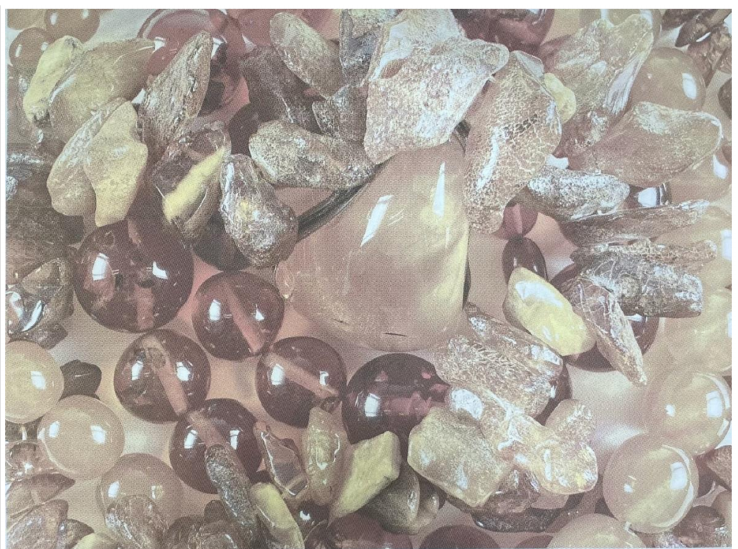
Figure A13. 25LPI screen-print, 55H mesh, Spectraval™ pigments, R = 400 g medium, 18 g pigment, G = 400 g medium, 24 g pigment, B = 400 g medium, 20 g pigment, black Plike, film negative, print size: 600 mm × 450